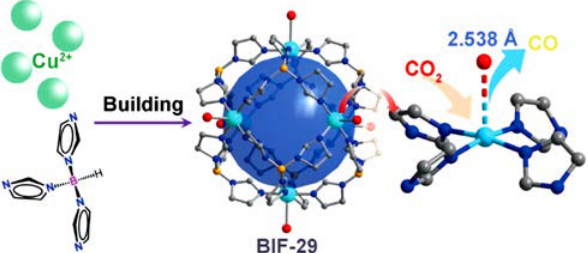
Figure 7. Schematic illustration of the synthesis of BIF-29 ( right ) and the CO 2 adsorption and activation over unsaturated coordinated Cu site ( left ). Broken line indicates weak bond to water oxygen atom. Cu, cyan; B, yellow; O, red; C, gray; N, blue. H atoms are omitted for clarity. Reprinted with permission from Reference 45.